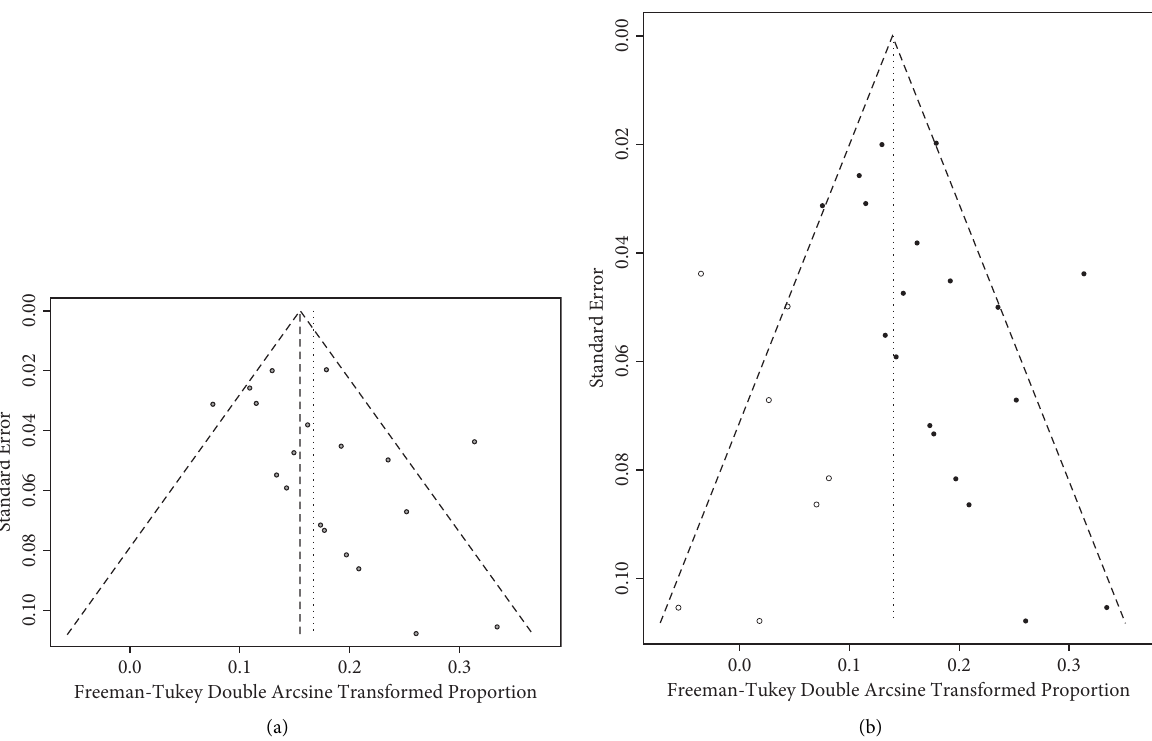
Figure 6: (a) The funnel plot displaying the pooled incidence rate of repositioning surgery of toric IOLs. (b) The filled funnel plot with pseudo-95% CI (the pseudo-95% confidence interval (CI) is computed as part of the analysis that produces the funnel